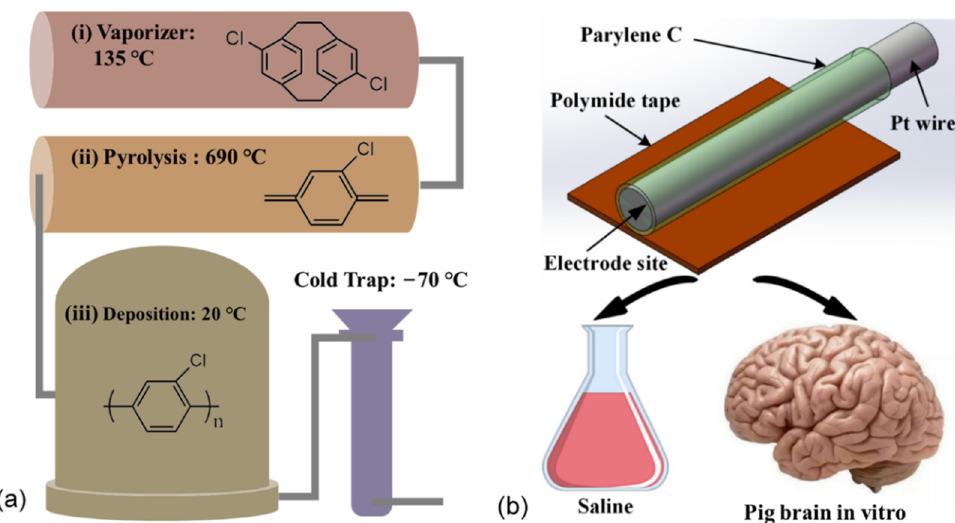
Figure 1. The schematic diagram of the experimental design. ( a ) The Parylene C coating was deposited by a chemical vapor deposition process. ( b ) The Pt wire electrodes were fabricated from a Pt wire with a diameter of 30 µ m coated with 5 µ m-thick Parylene C and then stuck to Polyimide tape for implantation. EIS measurements were performed for all the electrodes in both saline and pig brains in vitro.